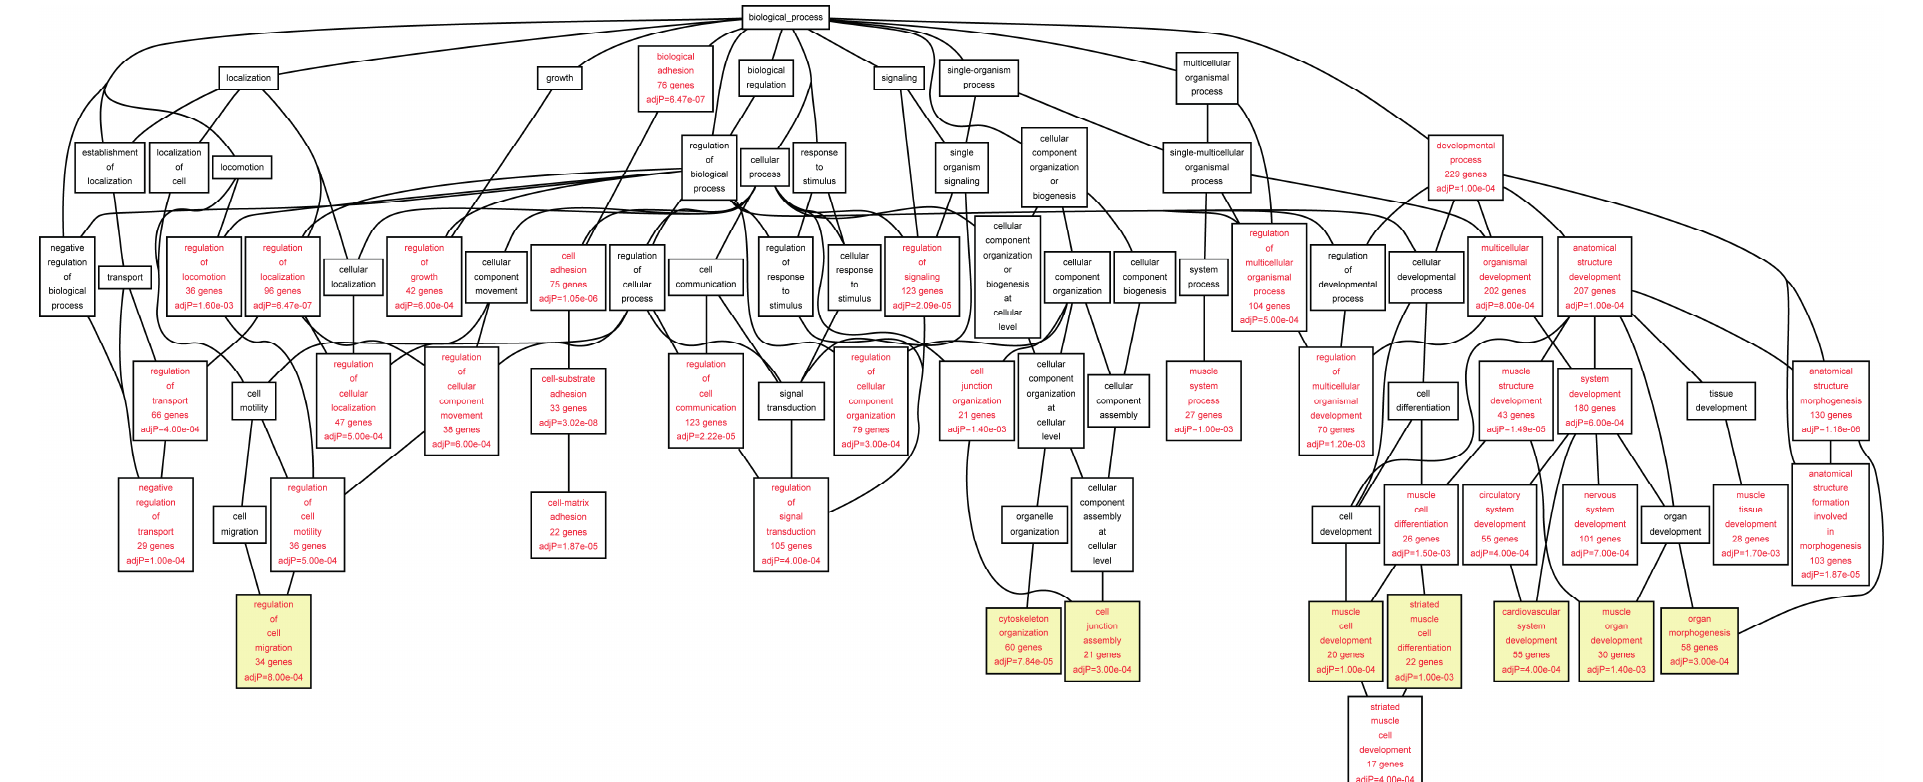
Figure 5. Biological categories of the down-regulated target genes of transcription factors RUNX1, ELF1, ETS2 and STAT5 in the AAA tissue. A DAG of the GO categories of the set of 551 genes was generated by the web application WebGestalt [32]. Categories shown in red were significant (adjusted p < 0.001). The categories on the 6th level of hierarchy are discussed in the text and are shown here with a yellow background. See Tables 8 and S7 for additional